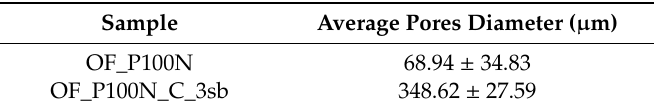
Figure 6. ( A ) Optical microscopy image of OF_P100N_one step [1]; ( B ) optical microscopy image of OF_P100N_C_3sb. Table 4. Average pore diameter of the P100N based samples with and without sodium bicarbonate (3% wt).